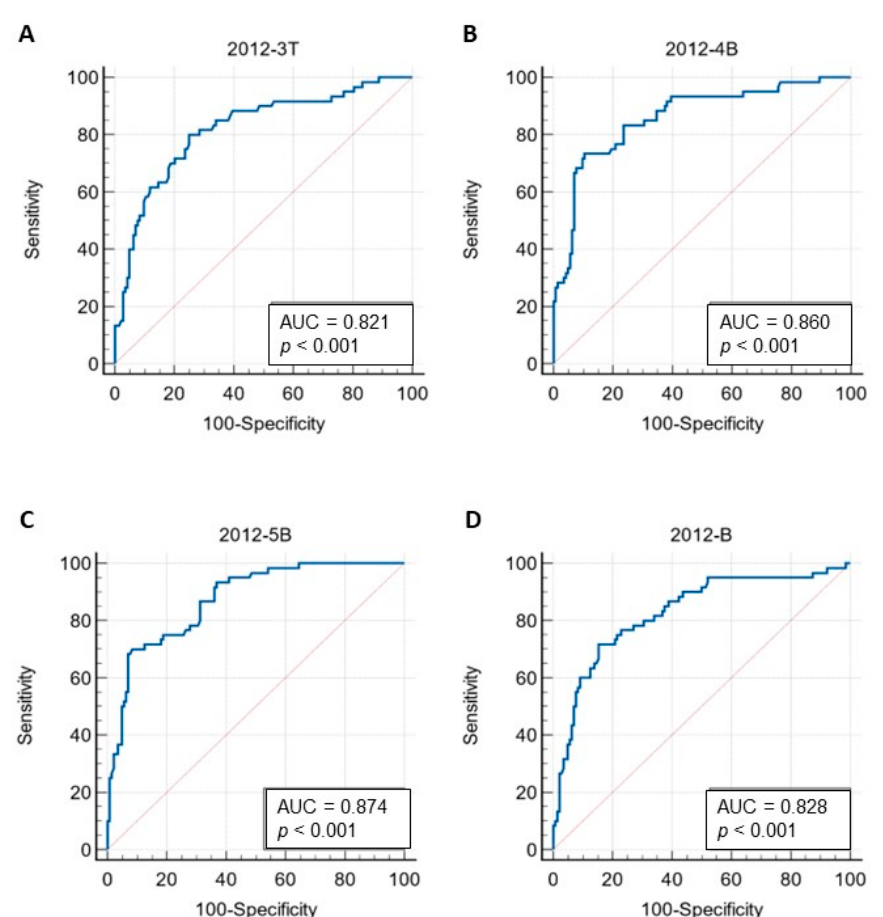
Figure 3. Receiver–operator curve (ROC) and area under the curve of ROC (AUC) of selected peptides tested with dog plasma samples by ELISA, 2012-3T ( A ), 2012-4B ( B ), 2012-5B ( C ) and 2012-B ( D ). ROCs of peptide ELISA were co-analyzed with the ELISA with LipL32 protein. The ROC and area under the curve (AUC) of each peptide were analyzed by MedCalc. Table 4. The performance of peptide-based ELISA evaluated with LipL32 antigen results. Peptide